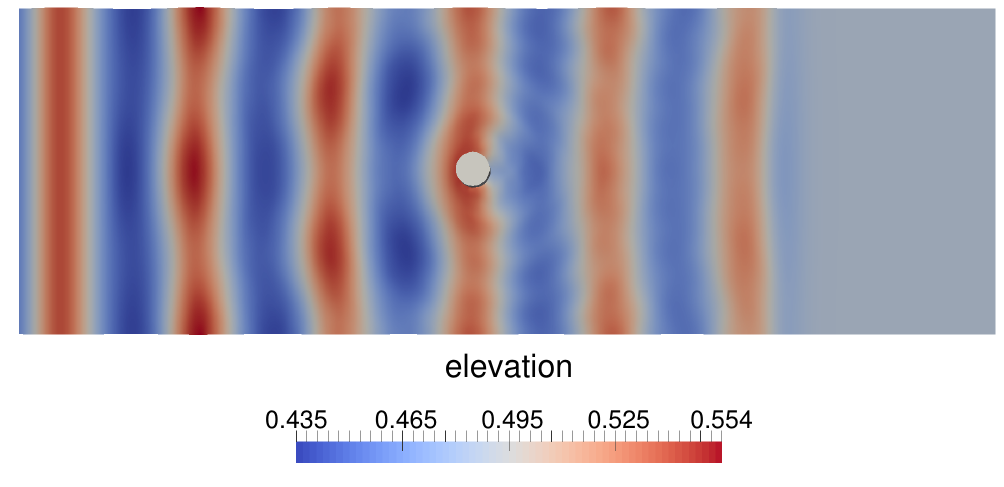
Figure 8. Free surface elevation in NWT at t = 38.3 s showing the wave reflection around the cylinder.